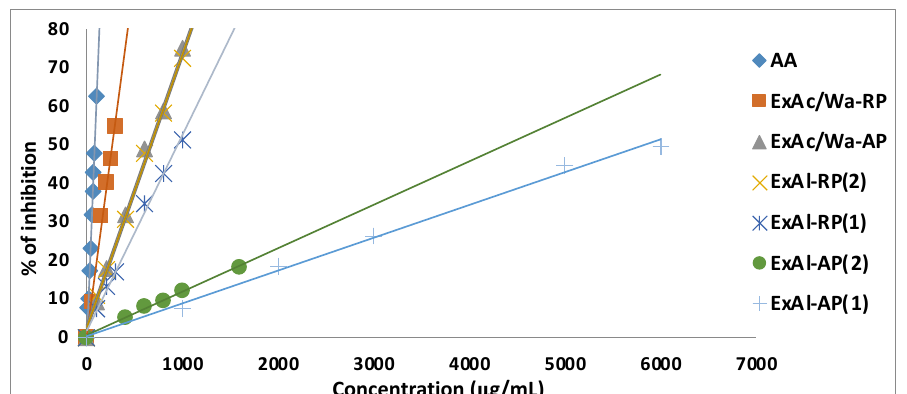
IGURE 4 - S traight, expressing the variation of the percentage of inhibition as a function of the concentrations of Haloxylon Scoparium extracts, obtained by the DPPH